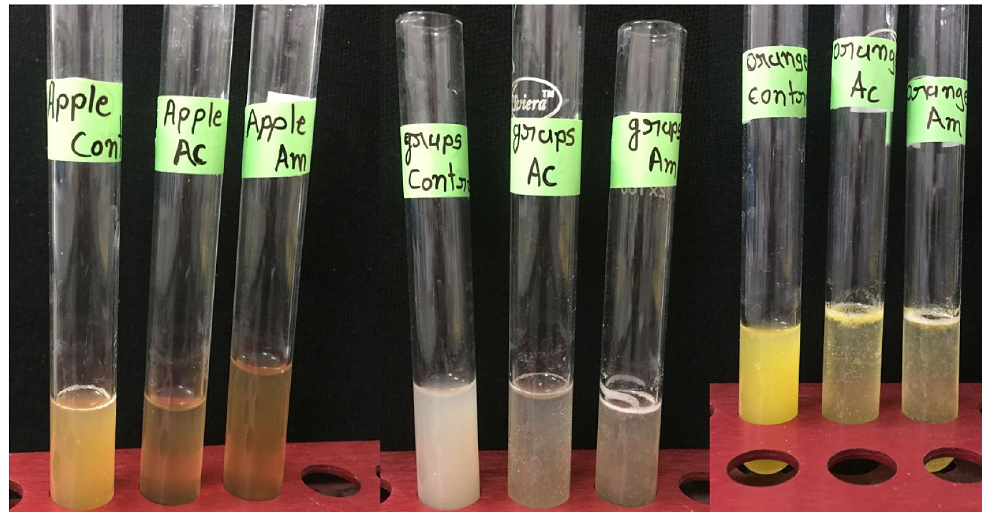
Figure 11. Application of Pectate lyase for fruit juice clarification Left, Centre, and